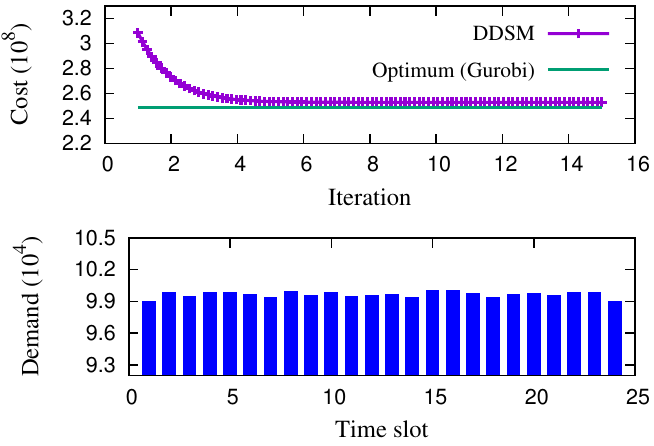
Figure 5. Convergence and peak load reduction properties of the distributed demand-side management algorithm (DDSM)